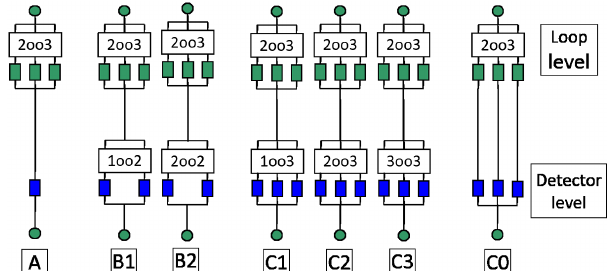
FIG. 14. Case II — Models of seven possible architectures for interfacing the interlock loop (green, “ loop level ” ) with detectors (blue, “ detector level ” ). Signal triggered by system demand (green, bottom) has to be transmitted and result in opening of loop (top).